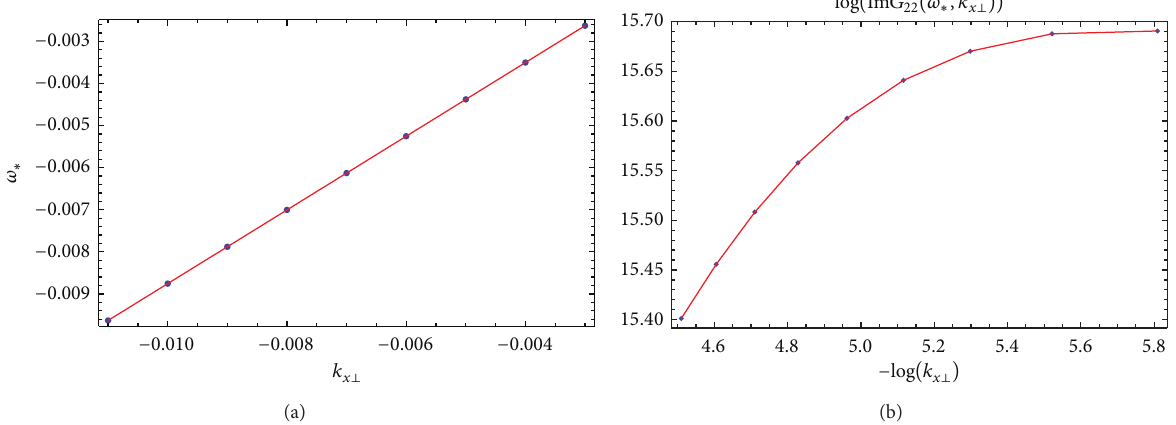
Figure 7: The dispersion relation (a) and the scaling behavior of Im 𝐺 22 (𝜔 ∗ (𝑘 𝑥⊥ ), 𝑘 𝑥⊥ ) (b) for 𝑎 2 = −0.01 .